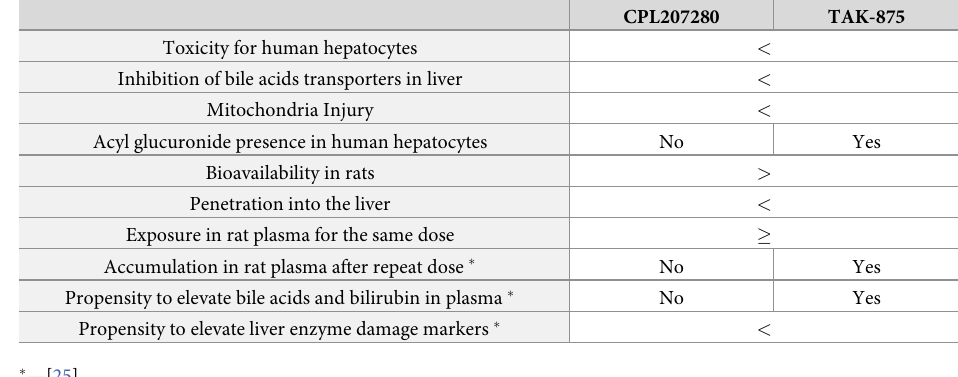
Table 5. Summary of the comparative literature and features of CPL207280 and TAK-875.